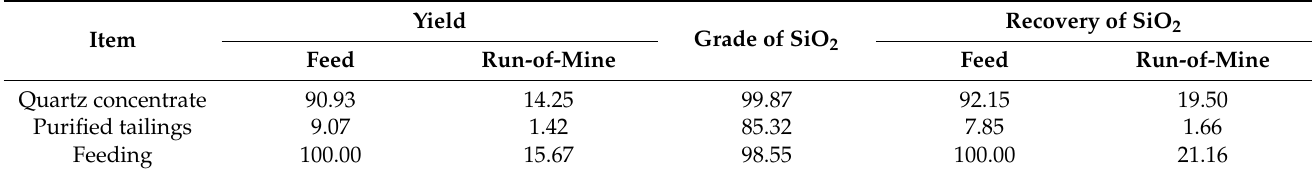
Table 11. Quartz purification results (mass fraction,